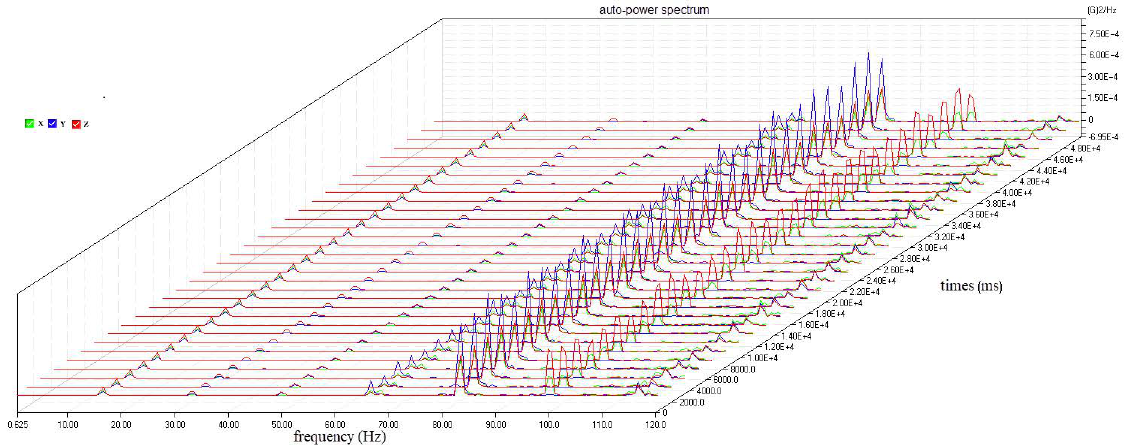
Figure 7. Waterfall diagram of the auto-power spectrum for the dynamic balance state.